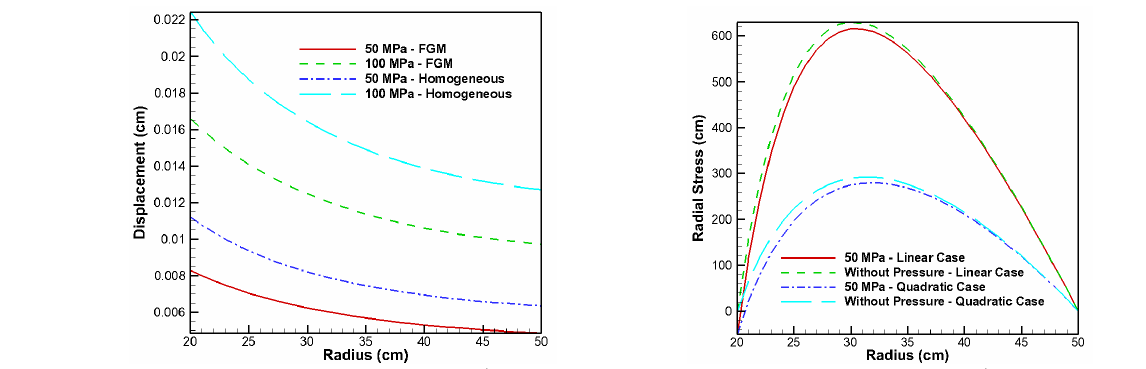
= 50, 100 MPa Figure 8. Radial stress: 𝑞 𝑖